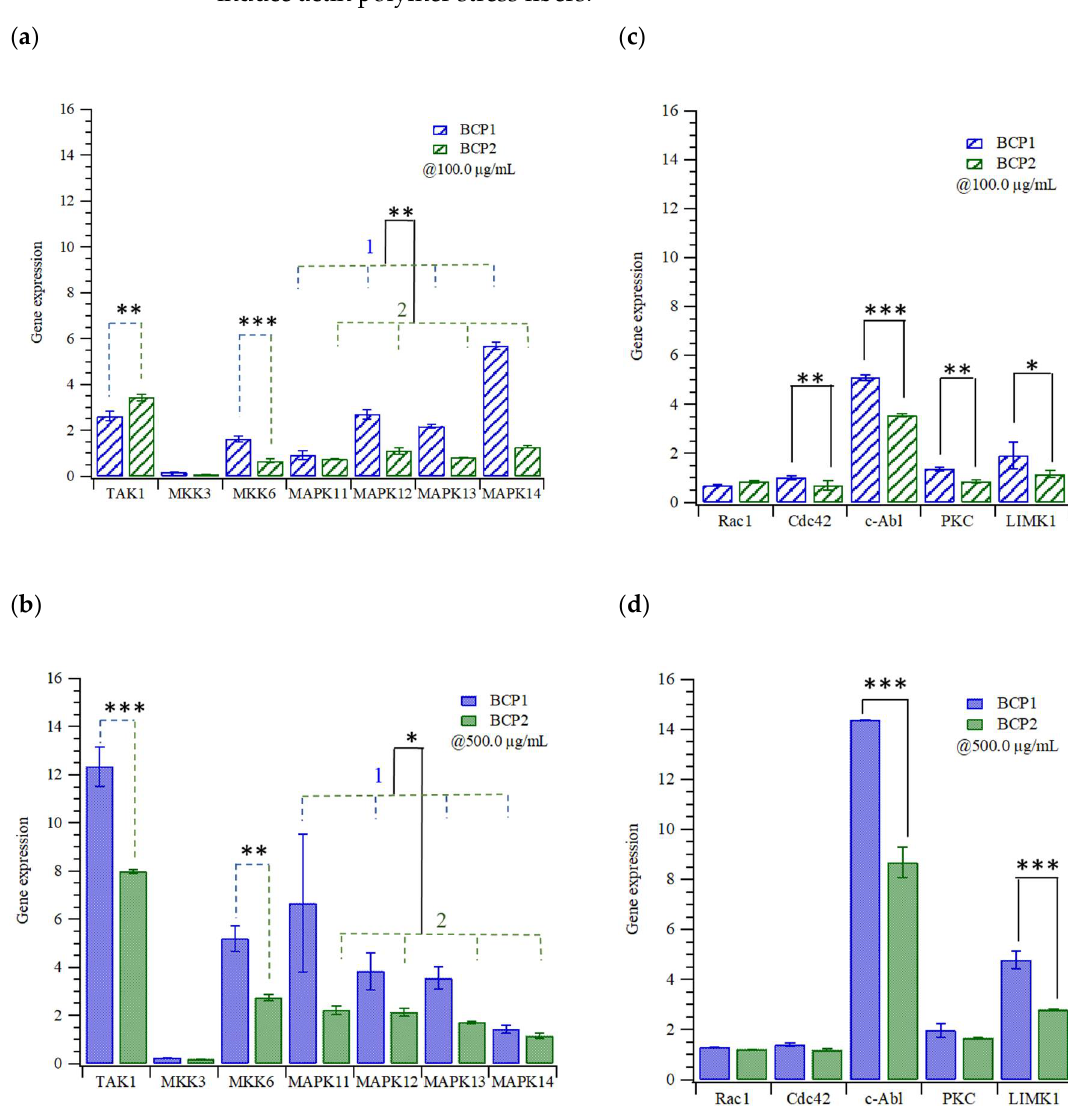
Figure 6. Expression levels in iPSCs with ( a , c ) 100 and ( b , d ) 500 μg/mL of BCPs for the ( a , b ) cellular stress proteins or ( c , d ) adhesion/interaction proteins (* p < 0.05; ** p < 0.005; *** p < 0.0005).